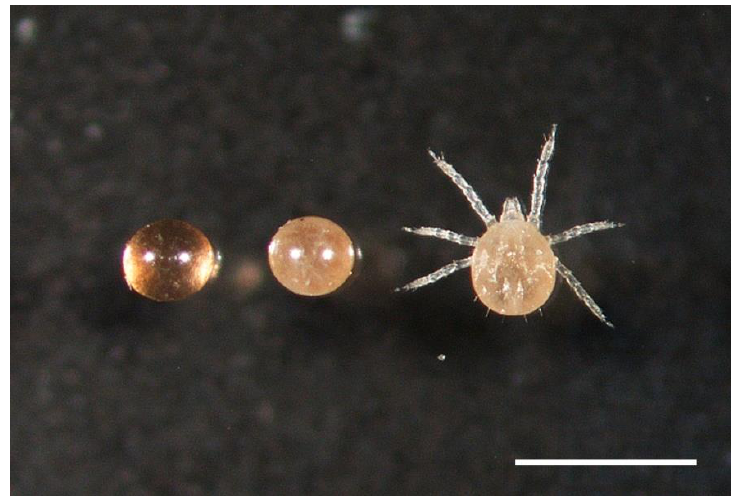
Figure 2. Ornithorodos hermsi unembryonated egg ( left ), embryonated egg ( middle ) and unfed larva ( right ). Scale bar = 1.0 mm.